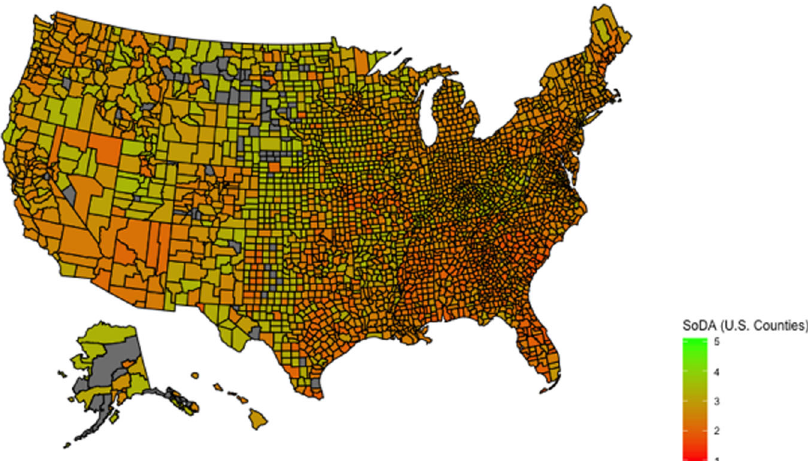
Fig. 3 COVID-19-related features model results heat map by United States county. Authors ’ analysis of authors ’ model based on data from the unacast social distancing dataset between from March 16, 2020 ( fi rst day of the national stray at home order) to April 24, 2020 ( fi rst day a state relaxed the social distancing guidelines), CDC, and CNN news reports. States that are grey did not have suf fi cient amount of cellphone data to be included. HUMANITIES AND SOCIAL SCIENCES COMMUNICATIONS| (2021) 8:87